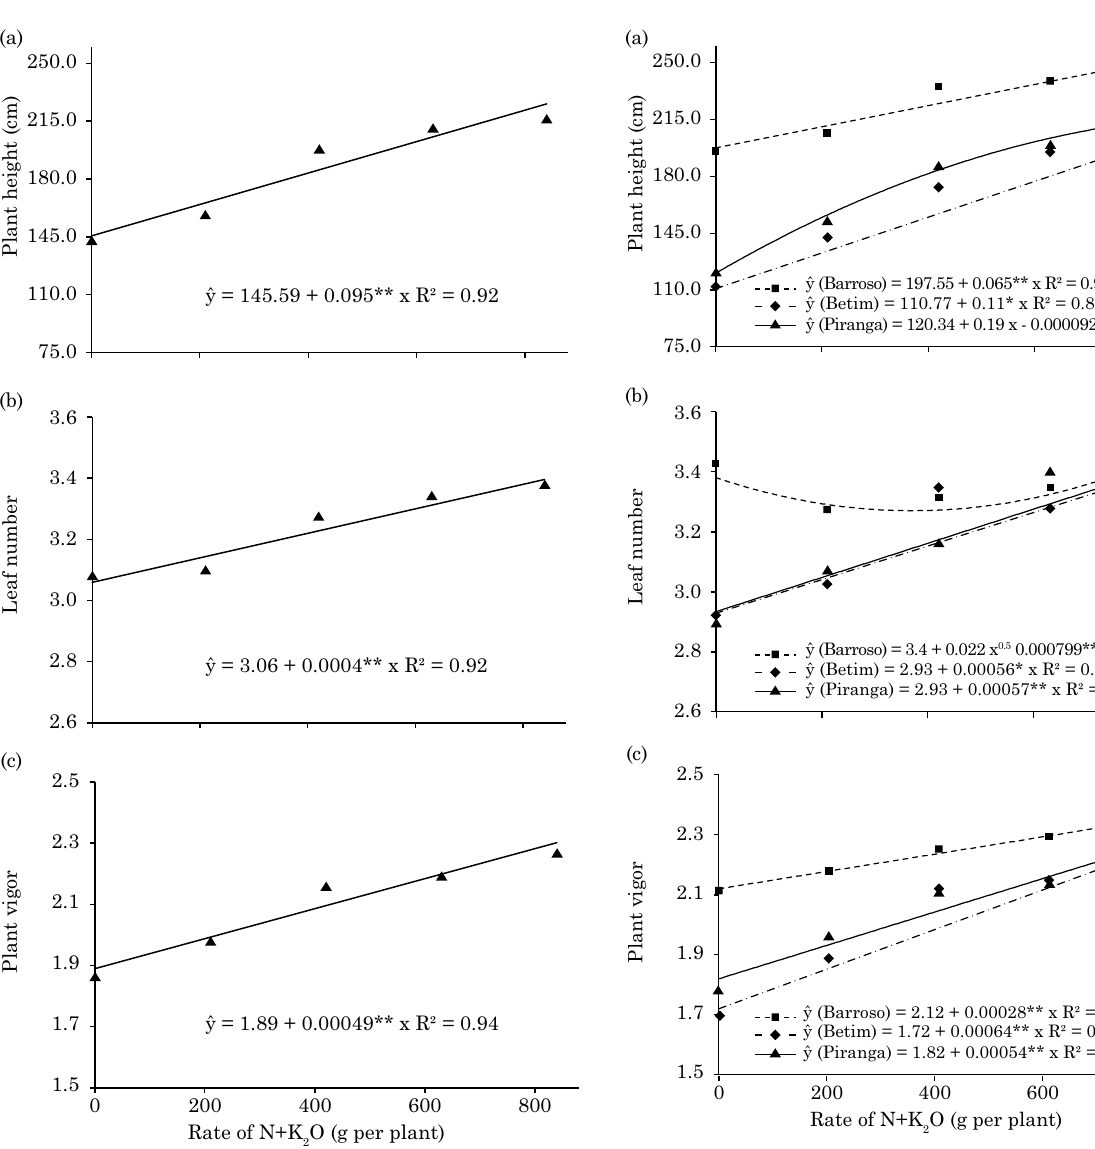
figure 1. Plant height (a), plant vigor (b) and leaf number (c) of macaw palm plants in response to five side-dressed N and K rates, estimated in the second year of field cultivation. **: significant at 1 % by the t test.